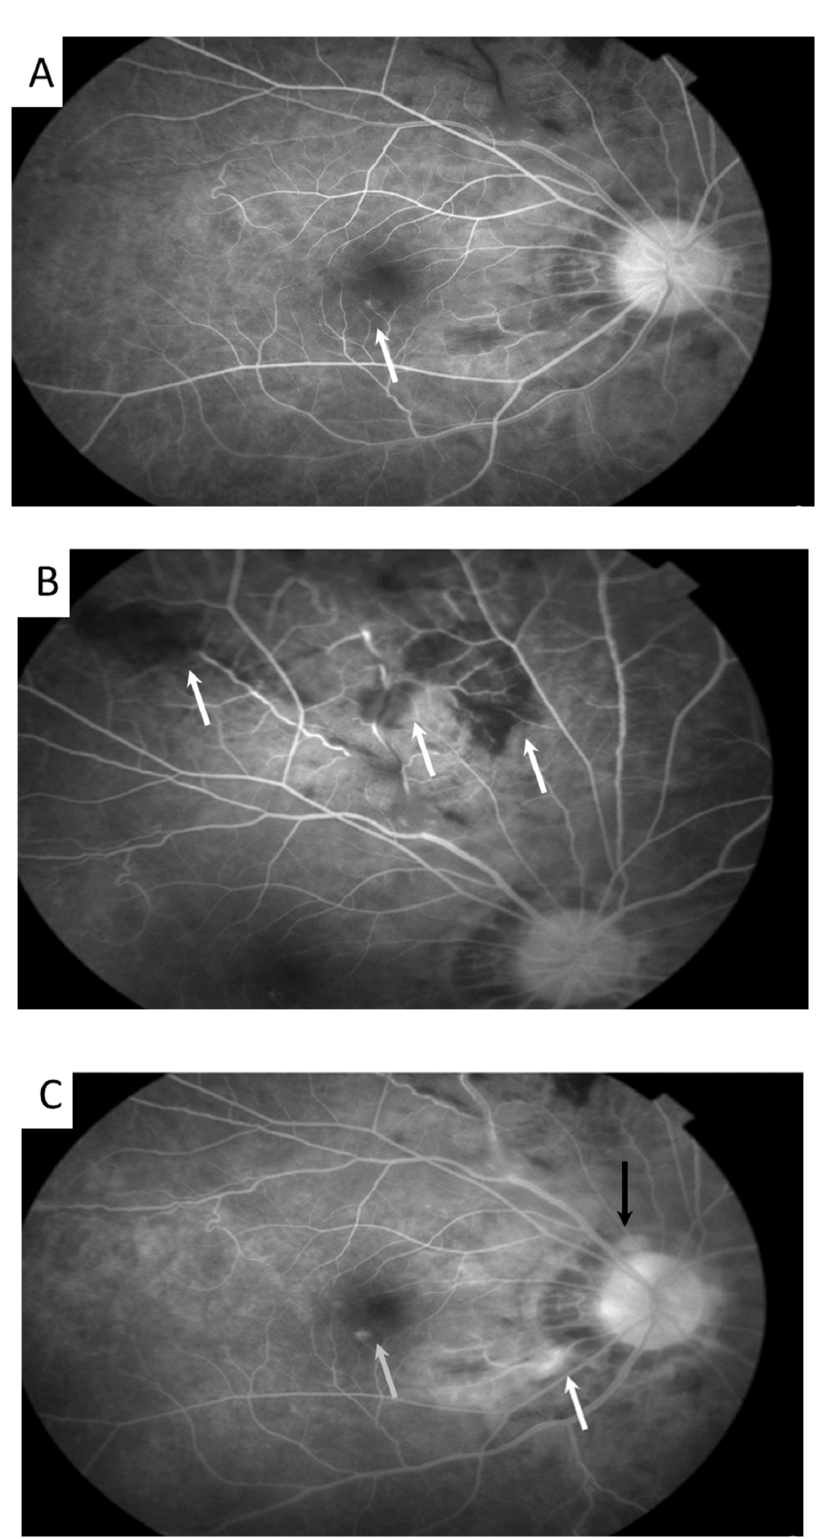
Figure 2. Traditional fluorescein angiography showed aneurysmal dilation (( A ), 40 s after the fluorescein injection, arrow) of peripapillary and optic disc retinal arterioles, peripheral capillary nonperfusion (( B ), 1 min after the fluorescein injection, arrow), focal inflammation of the optic nerve (( C ), 4 min after fluorescein injection, black arrow), peripapillary retina (( C ), white arrow), macula (( C ), gray arrow), and retinal vasculitis in the right